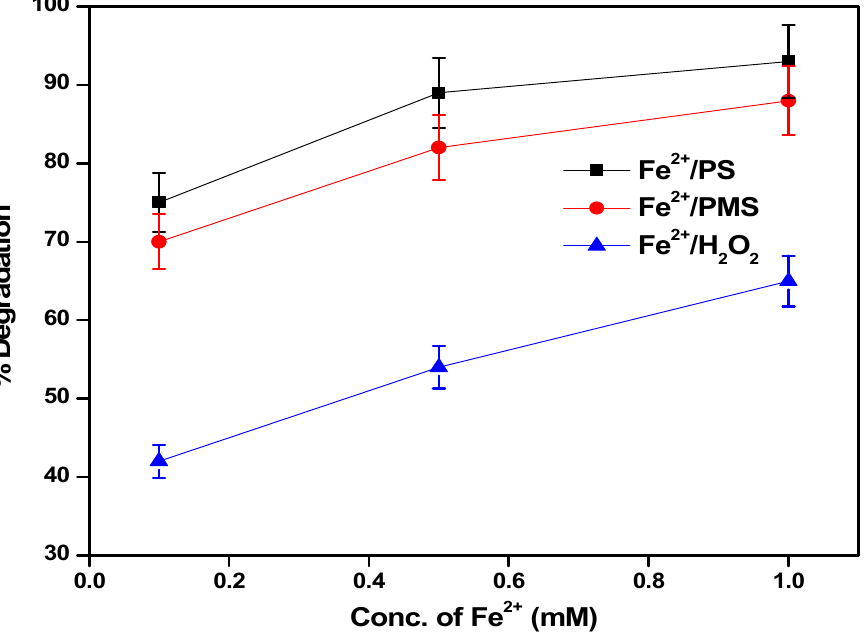
Figure 6. Effect of the initial concentration of Fe 2+ on the degradation of DCF sodium by the Fe 2+ /H 2 O 2 , Fe 2+ /PS and Fe 2+ /PMS systems. Reaction conditions: [DCF sodium] 0 = 0.5 mM, [Fe 2+ ] 0 = 0.1–1.0 mM, [H 2 O 2 ] 0 = [PS] 0 = [PMS] 0 = 10 mM, pH = 4.